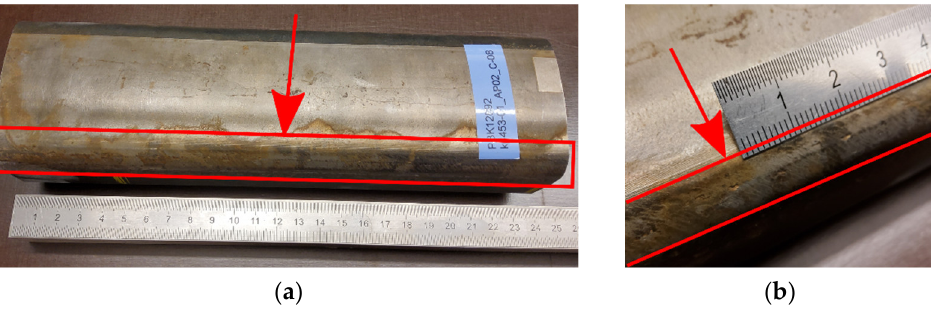
Figure 1. ( a ) A 250 mm long rail piece with head checks (RP01); ( b ) detailed view of the head checks on the gauge corner; area with head checks marked in red.